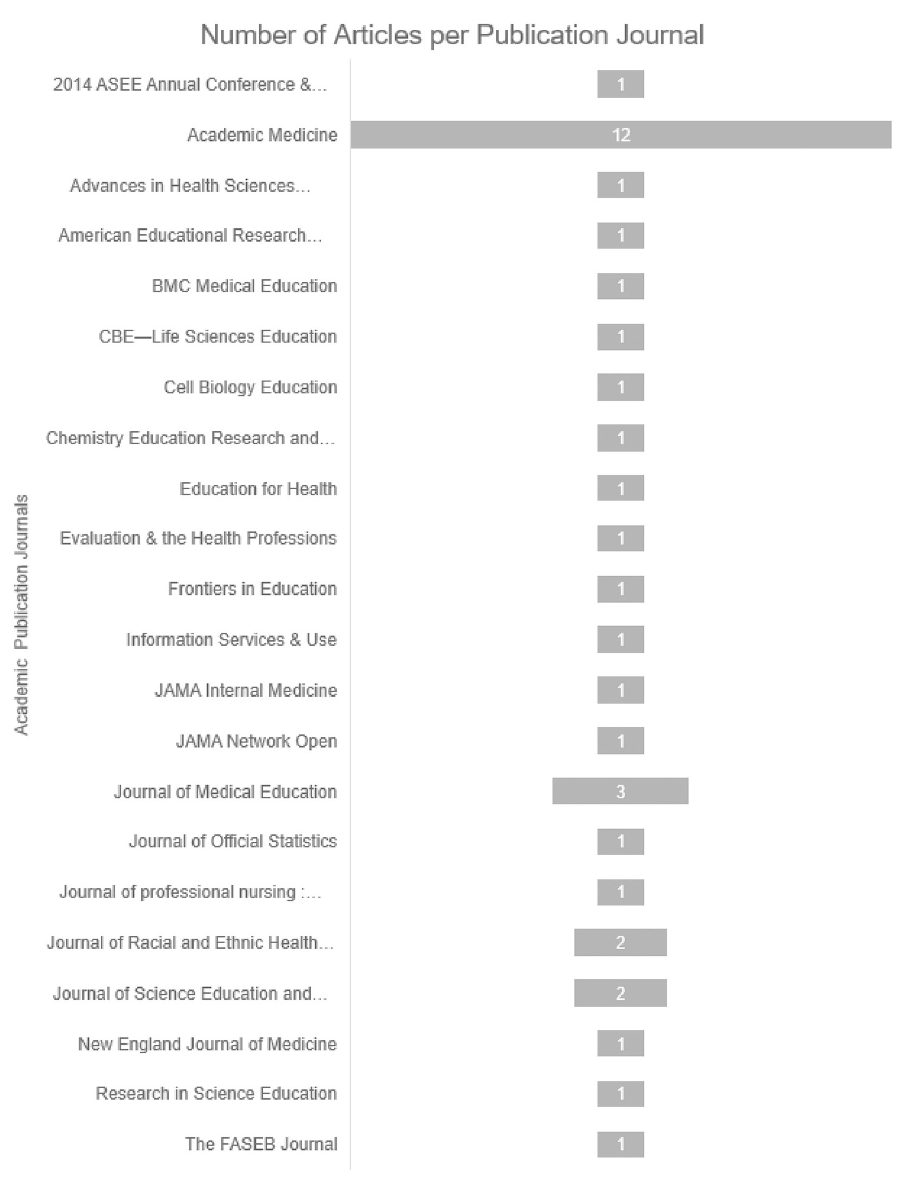
Fig 3. Chart illustrating the number of articles per publication journal for the literature review (N = 37). Most of the articles are from the Journal of Academic Medicine (n = 12).